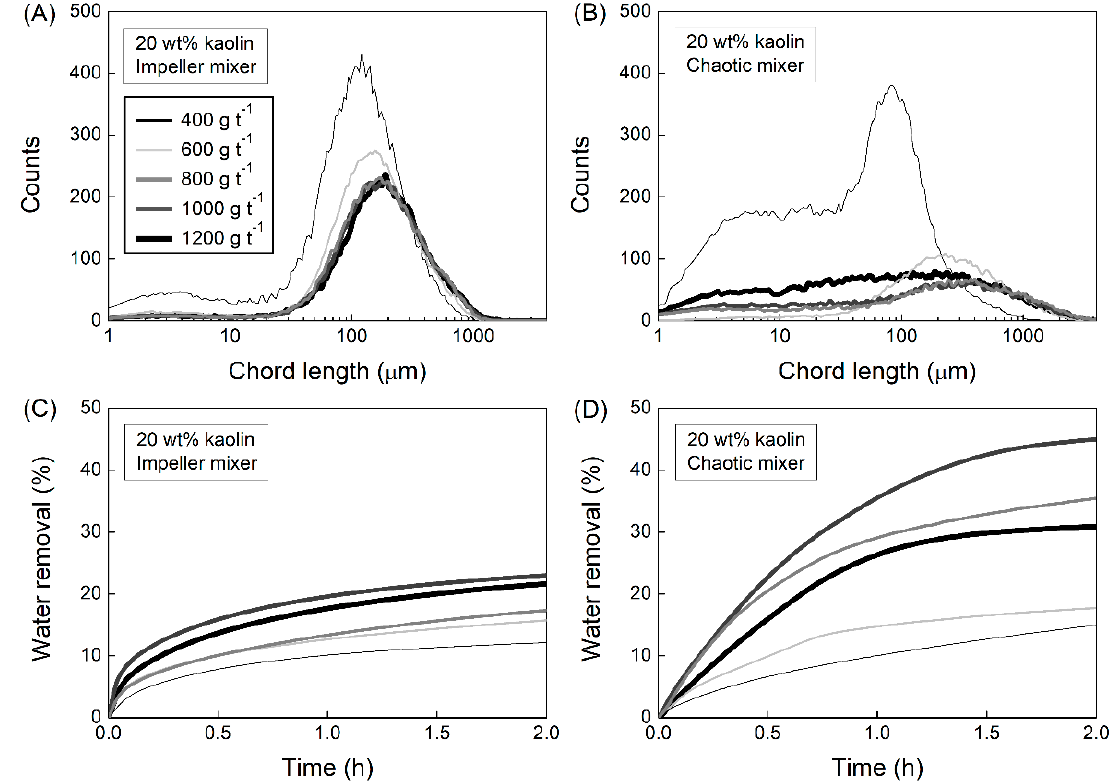
Figure 4. ( A , B ) Unweighted chord length distributions for 20 wt % kaolin as a function of Magnafloc ® 336 dosage and mixer type. ( C , D ) Corresponding net water recovered after 2 h.